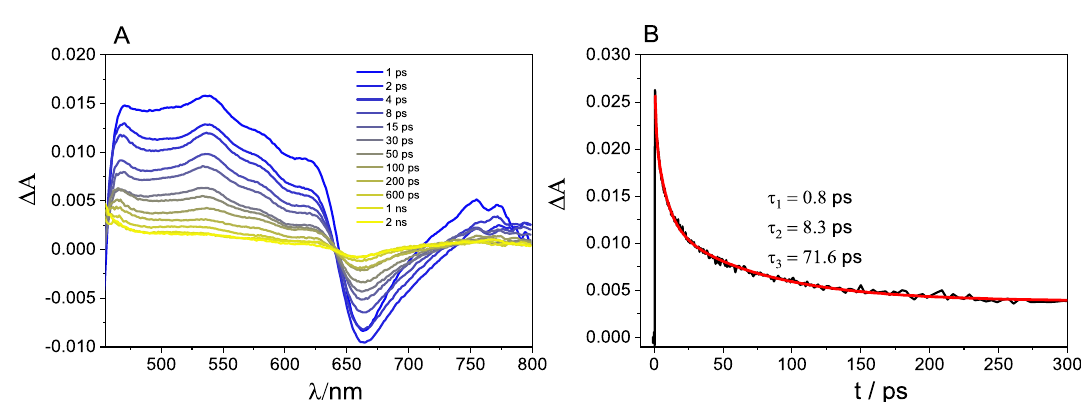
Figure 10. ( A ) Transient absorption spectra registered at various time delays and ( B ) absorption time profile probed at 550 nm measured for TPPNH 2 in the presence of GO (GO concentration 0.4 mg mL −1 ) in DMF-H 2 O (1:2, v/v) following the 440 nm laser excitation. Transient absorption spectra and kinetics are corrected for GO